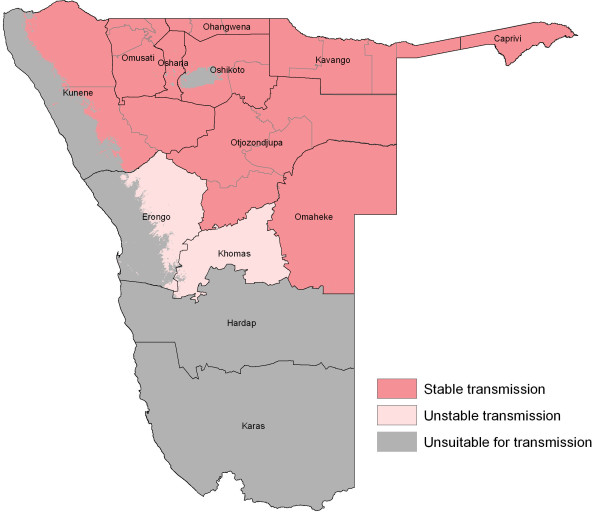
Map of current first level administrative units (black line) and health districts (grey line) of Namibia showing the spatial limits of P. falciparum transmission. Predictions of receptive and current PfPR2-10 were restricted to the stable limits of transmission. Approaches used to constructing the spatial limits of P. falciparum transmission for Namibia are provided in [11].